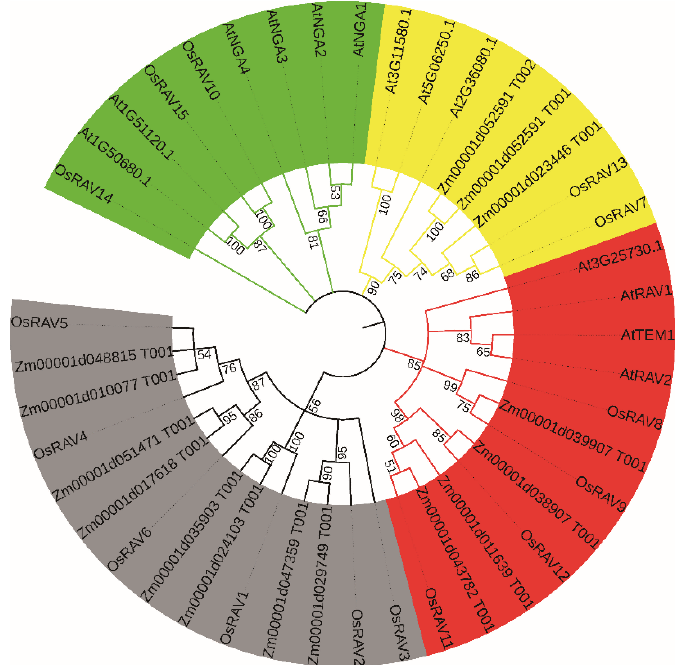
Figure 1. Phylogenetic relationship of RAV family proteins in rice. The phylogenetic tree was produced using MEGA-X software based on the comparison of amino acids of the RAV proteins. The neighbor-joining method was used with 1000 bootstrap replicates. ( A ) Neighbor-joining phylogenetic tree of the RAV family in Os ( Oryza sativa ). ( B ) Conserved motif distributions of the RAV proteins in rice. The B3 domains and AP2 domains are indicated by the green and yellow boxes, respectively.